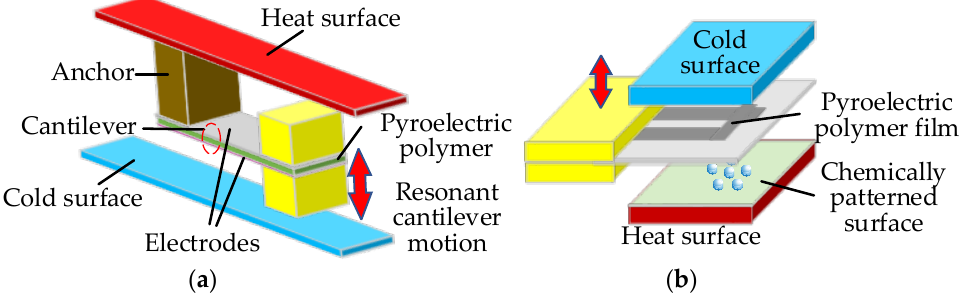
Figure 10. Schematics of typical pyroelectric generators: ( a ) Cantilever structure; ( b ) With liquid-based